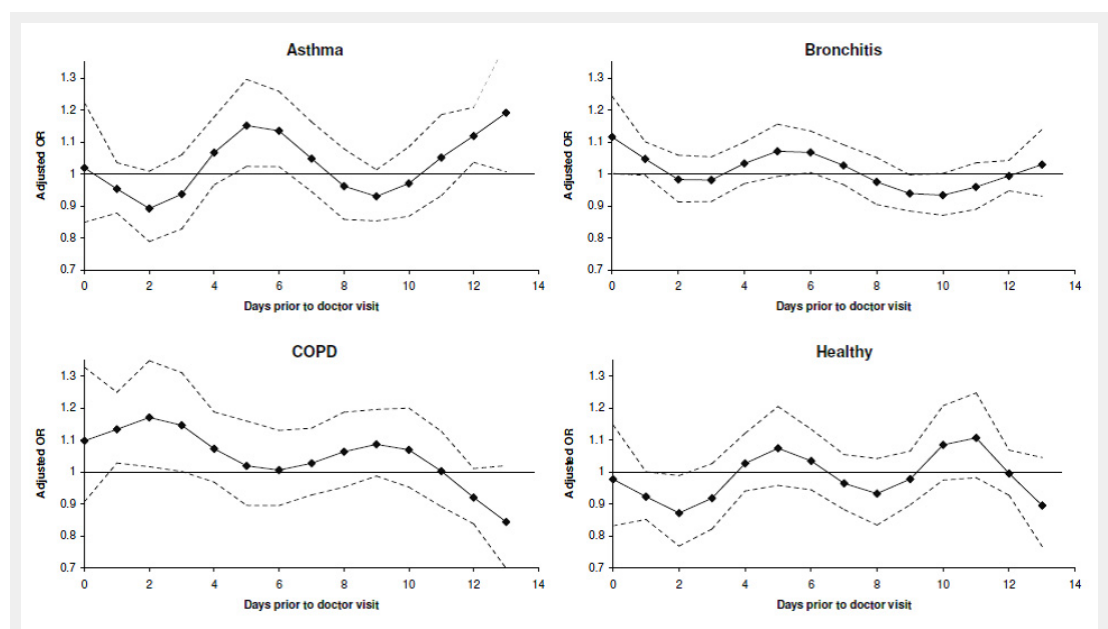
Figure 1 Adjusted OR’s * for doctor’s visit for respiratory symptoms per 10 µg/m 3 increase in NO 2 . * As estimated in separate conditional logistic regression models in the asthma, chronic bronchitis, COPD, and healthy subgroups, and adjusted for flu prevalence, polynomial distributed lags of T, RH, AP, T 2 , RH 2 , and T*RH from lag 0–6 days at up to 2 degrees of freedom, and average T, RH, AP, and T 2 from lag 7–13 days.